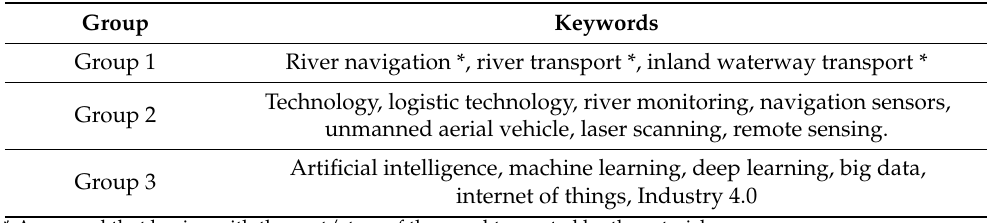
Table 1. Keywords used for the search queries.